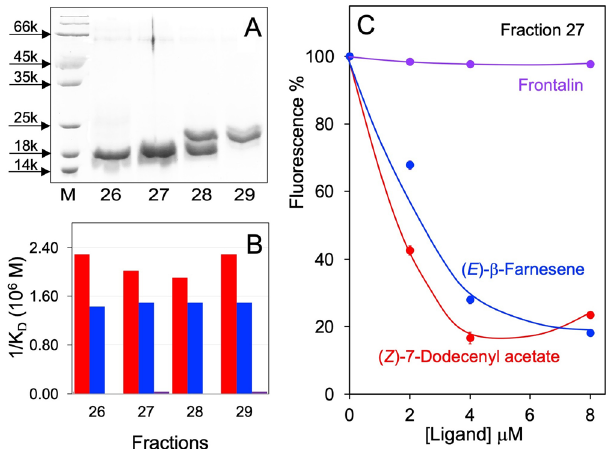
Figure 2. ( A ) Fractionation of a crude extract of trunk wash from the African elephant by anion-exchange chromatography. SDS-PAGE analysis of the fractions showing electrophoretic bands in the low molecular weight range (15–25 kDa). ( B ) Summary of the affinities to ( Z )-7-dodecenyl acetate, ( E )-β-farnesene and frontalin measured with crude samples of the same fractions. All of them bound with good affinity both ( Z )-7- dodecenyl acetate and ( E )-β-farnesene. Also farnesol, proved to be as good a ligand as ( E )-β-farnesene, whereas exo -brevicomin did not show any affinity. Dissociation constants were evaluated using the procedure adopted when dealing with solutions of a pure protein; as this is not the case, the values have to be taken as a crude indication of the affinity of the ligands for the protein. ( C ) Examples of the competition curves measured with the three ligands on fraction